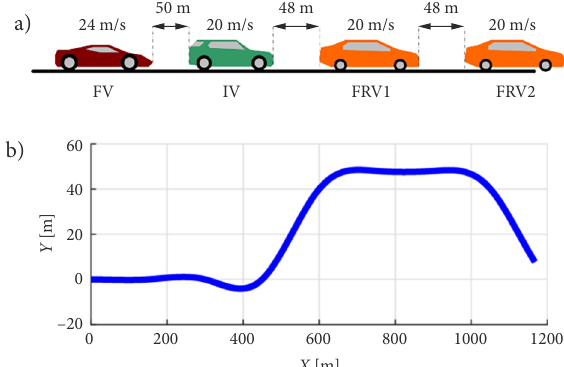
Figure 13. Initial motion states and path (source: created by the authors): a – initial speeds and clearances; b – path; FV – following vehicle; IV – intelligent vehicle; FRV – frontal vehicle